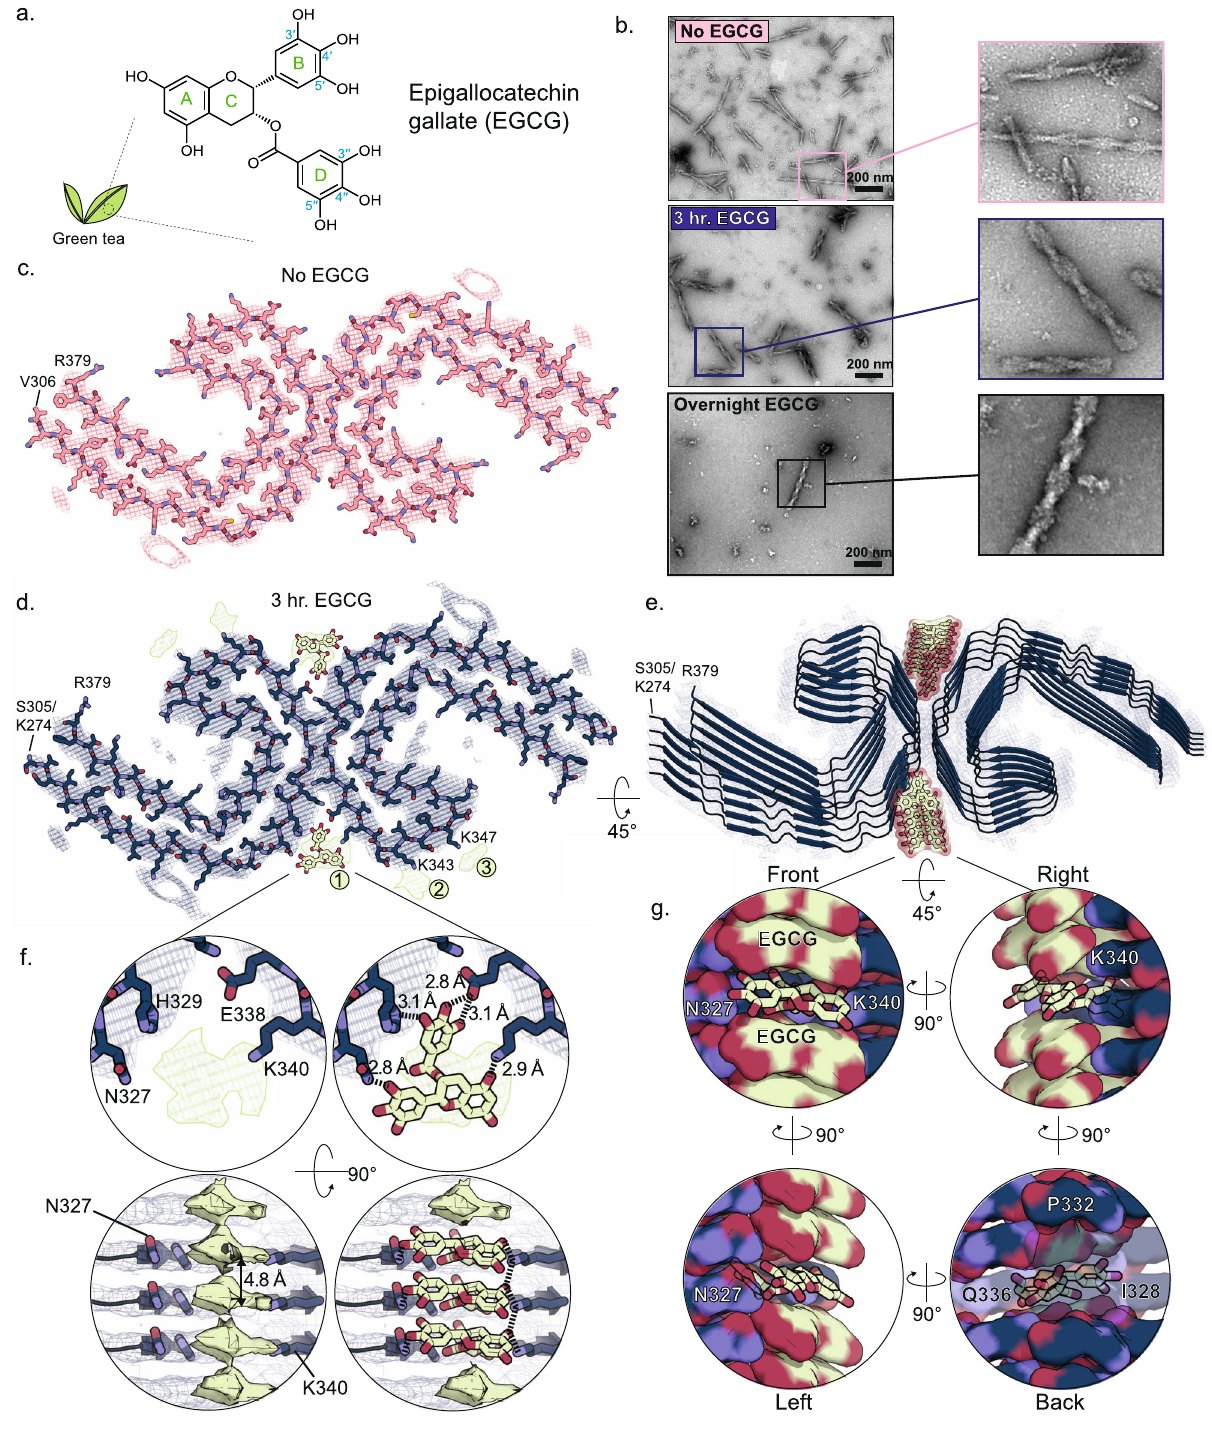
Fig. 1 | CryoEM structure of AD-tau PHF in complex with EGCG. a Epigallocatechin gallate (EGCG) is the most abundant polyphenol in green tea. It includesabenzenediolring (A)adjoined toatetrahydropyranmoiety(C), whichare connected to a galloyl ring (D) and pyrogallol ring (B). The 8 hydroxyl groups allow EGCG to engage in hydrogen bonding and other polar interactions with numerous biomolecules. b Electron micrographs of brain-derived PHFs over the course of EGCG incubation. Without EGCG (top), numerous fi brils are observed (representa- tiveimagefrom n =15).After3-hincubationat37 °C(middle),subtlechangesinthe fi brilmorphologyarepresent,withawideningofthe fi brilfuzzycoat(representative imagefrom n =15).Farfewer fi brilsareseenatthistimepoint.AfterovernightEGCG incubation (bottom), the rare remaining fi brils appear swollen and disturbed (representative image from n =8). c Cross-sectional view of the AD patient brain- derivedtauPHFcryoEMstructurebeforetheadditionofEGCG. d TauPHFstructure